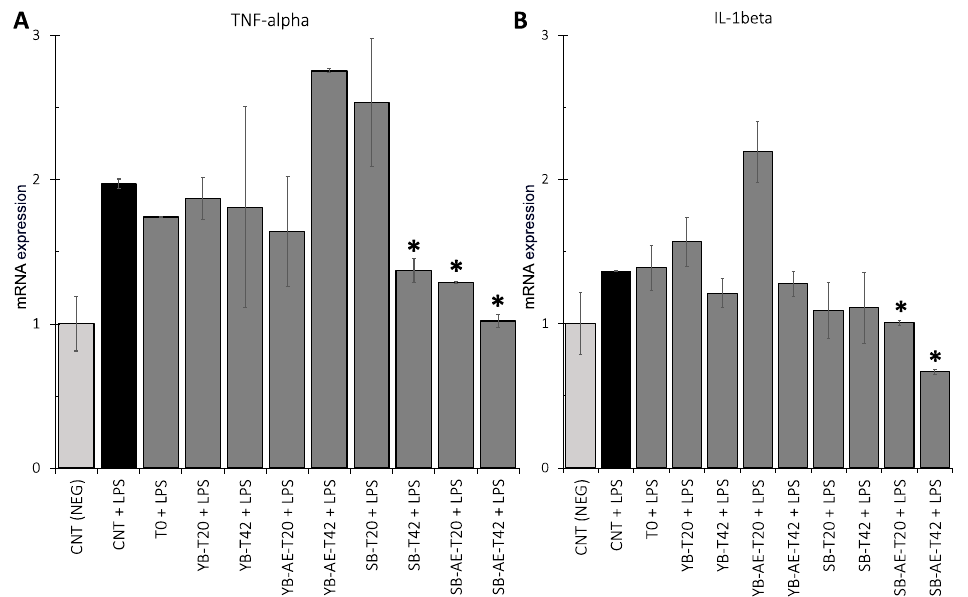
Figure 6. Tumor necrosis factor-alpha (TNF- α ) ( A ) and interleukin 1-beta (IL1- β ) ( B ) expression in Caco-2 cells exposed to LPS from E. coli trigger. Analyses were carried out in two independent experiments. The negative control (NEG CNT) was the medium for Caco-2 cell culture, while the positive control was CNT + LPS. Error bars are shown. Significance, labeled with “*”, was reached with a p -value < 0.05 comparing samples against CNT + LPS (one-way ANOVA test). Compared with the positive control, both supernatants of SB-AE (T20 and T42) sig- ( p > 0.05) from the negative control (Figure